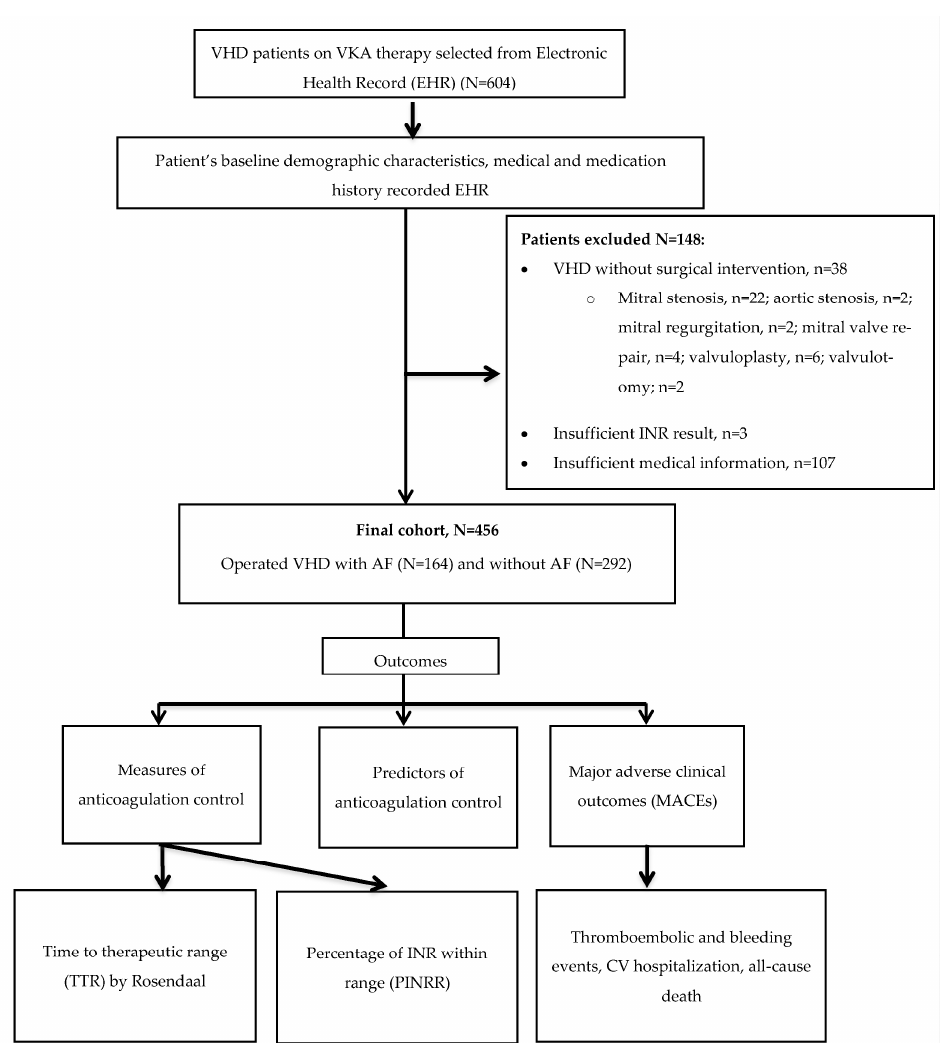
Figure 1. Study design and flow chart.